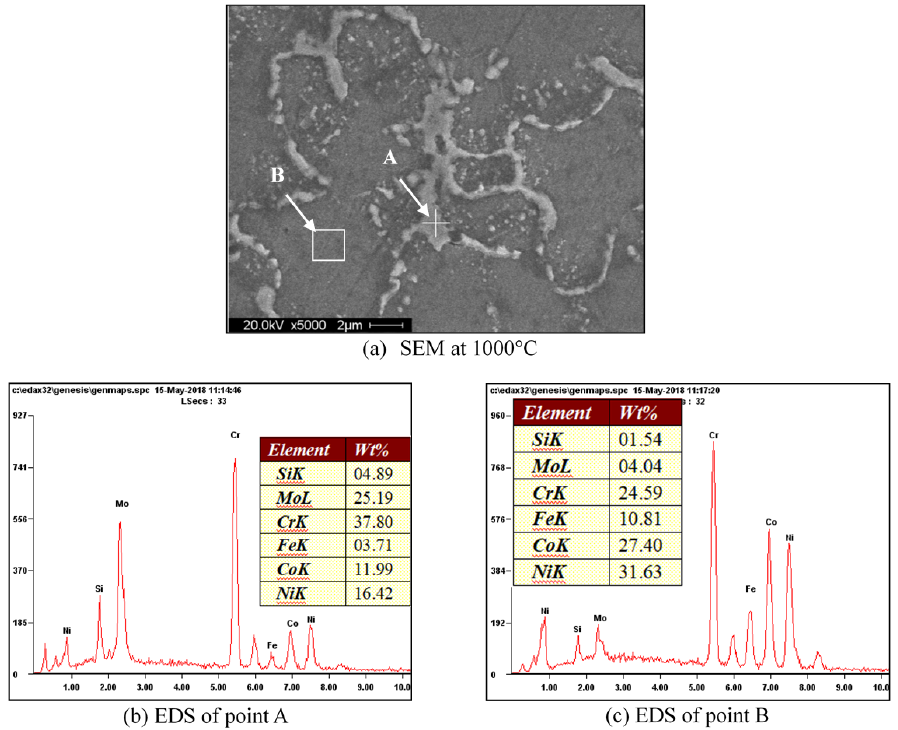
Figure 2. SEM and EDS of CoNiCrMo alloy for 1h at 1000°C solid solution